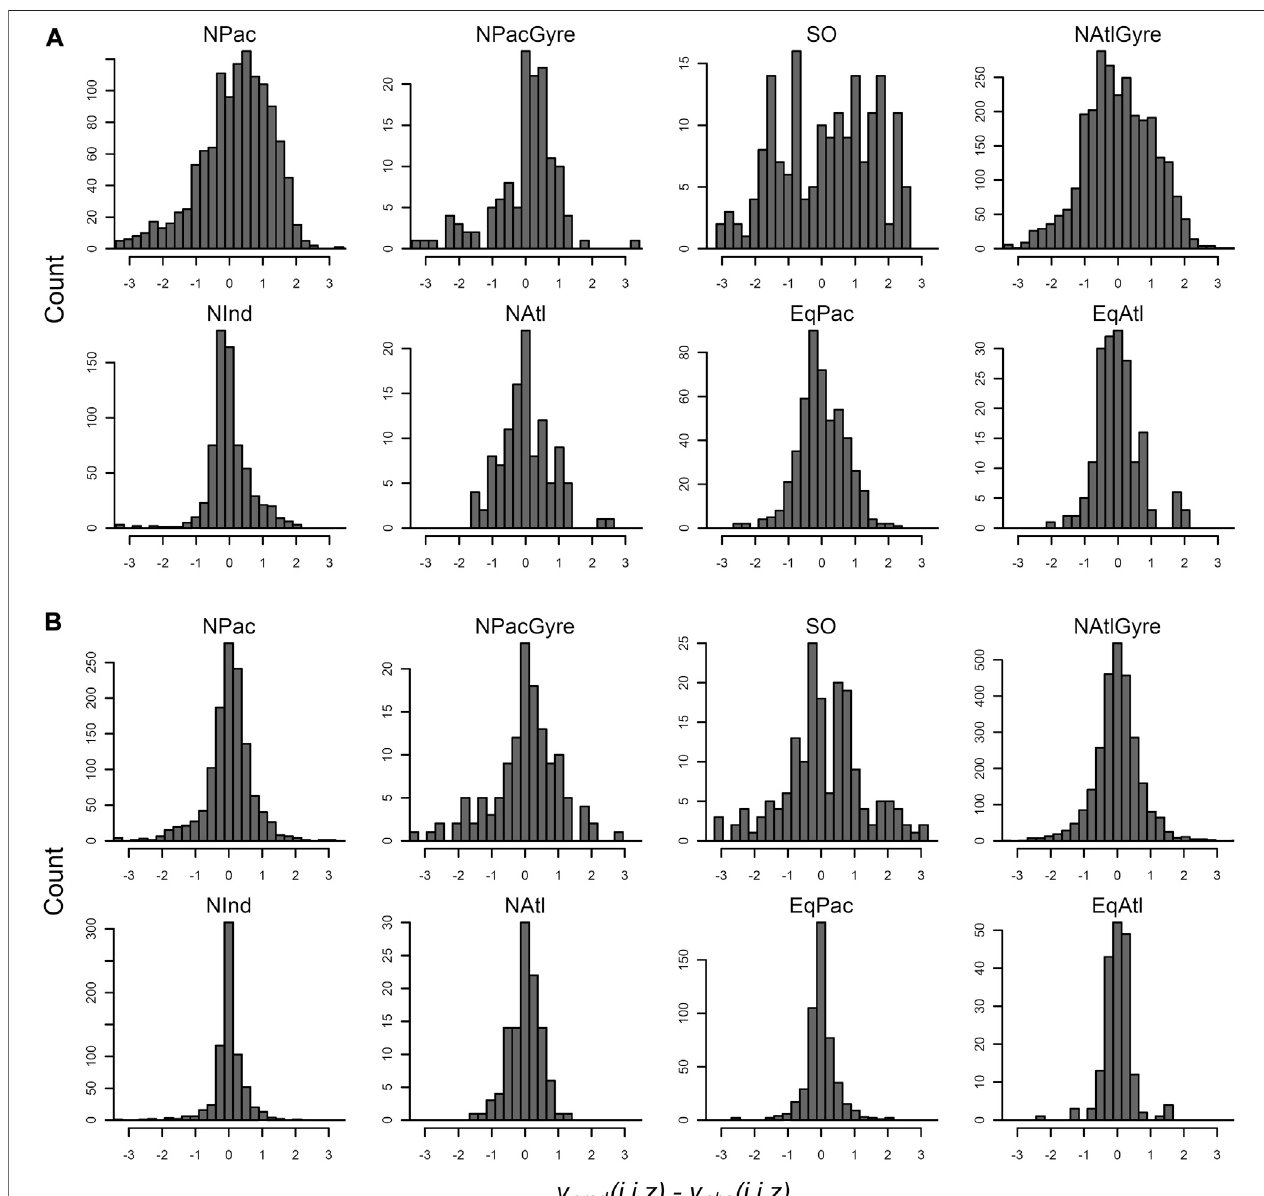
FIGURE 7 | Distribution of data-level residuals for the data-aggregation method (A) and the hierarchical analysis (B) . Residuals are evaluated at each latitude, longitude, depth combination, organized by biome-group. Residuals are for the hierarchical analysis are evaluated as the posterior mean prediction minus the